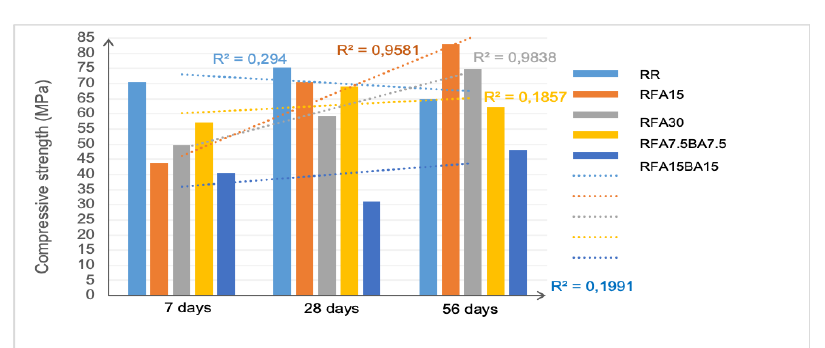
Figure 5 – Compressive strength test